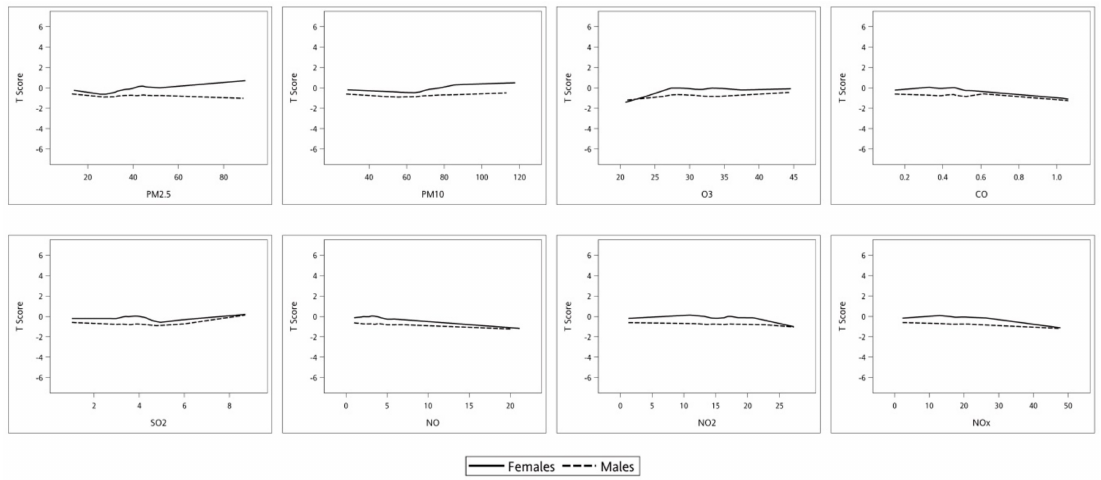
Figure 4. Association of air pollutants (A) PM 2.5 , (B) PM 10 , (C) O 3 , (D) CO, (E) SO 2 , (F) NO, (G) NO 2 , (H) NO x with BMD T-score in male and female participants. The interaction between sex and PM 2.5 ( p < 0.001), PM 10 ( p = 0.001), O 3 ( p = 0.021), CO ( p = 0.033), NO ( p = 0.007), and NO x ( p = 0.049), in the value of T-score were statistically